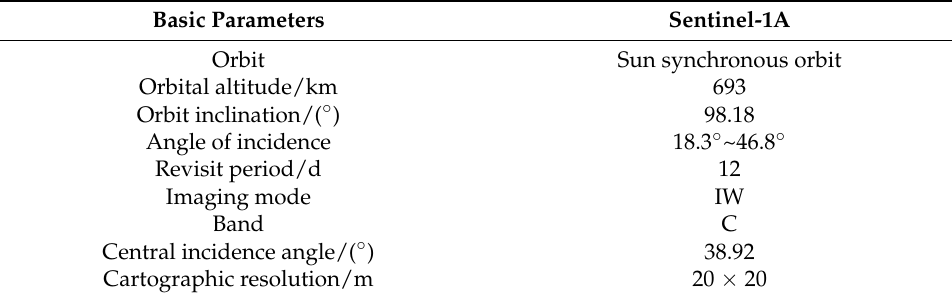
Figure 1. Study area. Table 1. Basic parameters of Sentinel-1A.